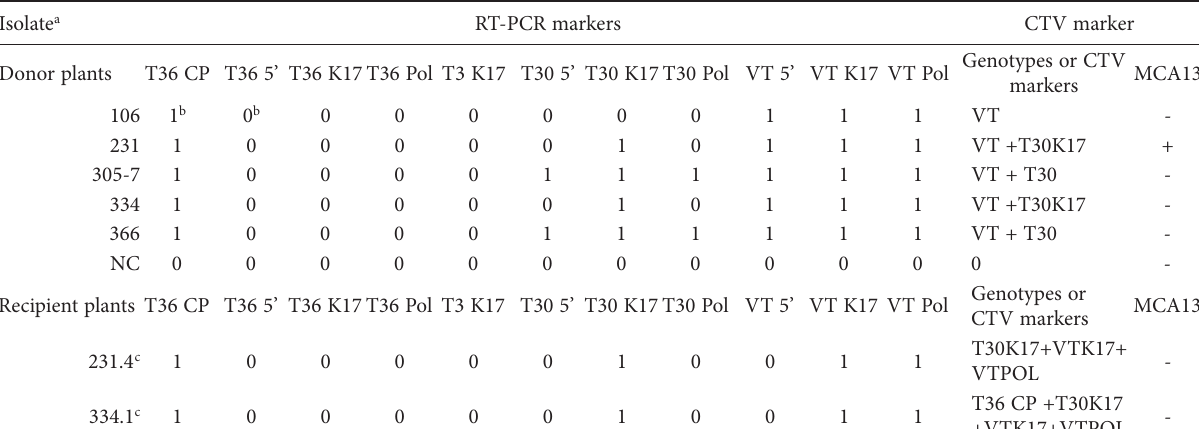
Table 3. Genotypes determination based on marker patterns obtained using the Hilf et al. (2005) methodology. Genotypes in infecting donor plants and CTV-positive recipient plants after transmission through Aphis gossypii. Isolate a